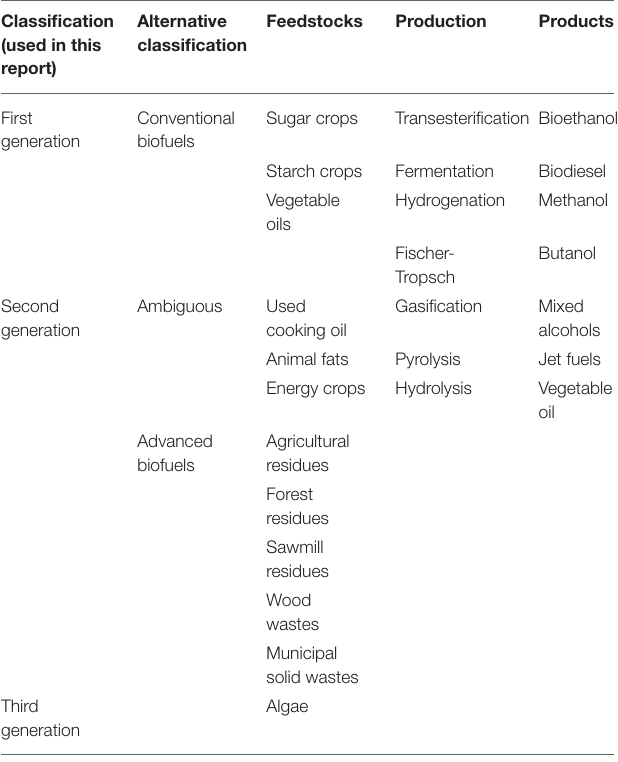
TABLE 3 | Classification of biofuels according to the type of feedstock, alternative classification and process technology (Royal Academy of Engineering, 2017). Classification (used in